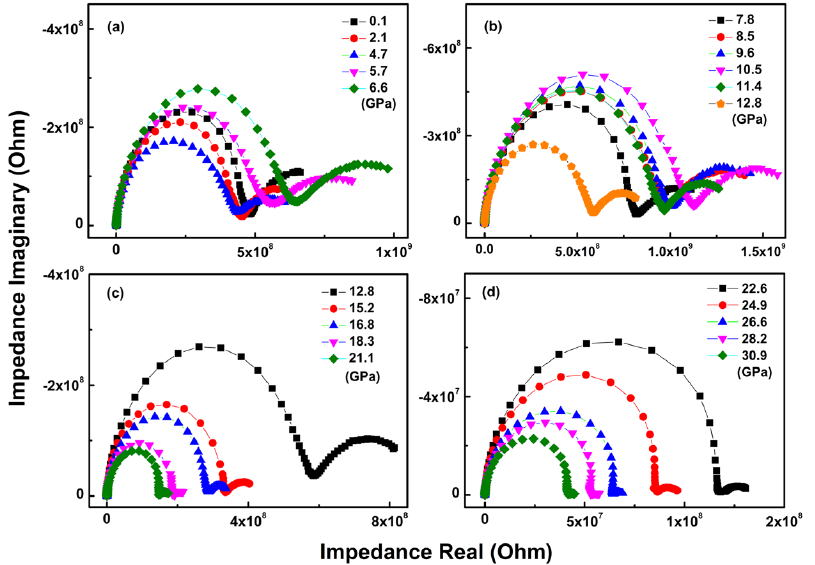
Figure 4. The Z I vs. Z R Nyquist plots of electrical impedance spectroscopy for the goethite sample inside a diamond anvil cell at different pressures, as labeled. The first semicircle of each data is the contribution from the grains (R g ), and the second semicircle is that from the grain boundaries (R gb ). The total resistance of the sample R = R g + R gb .